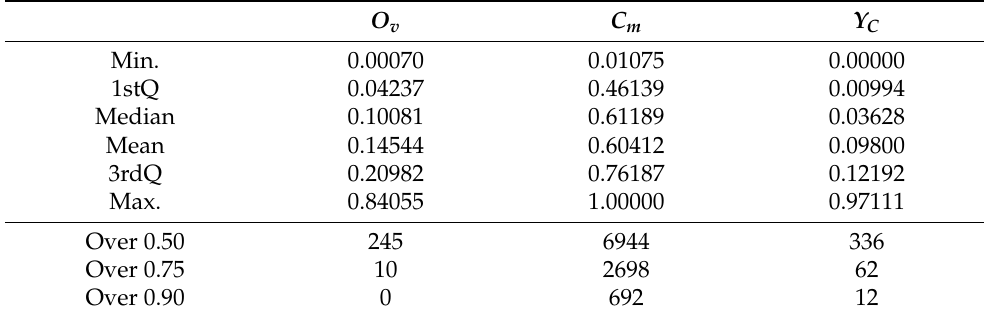
Table 2. Summary of similarity values between pairs of quasispecies.